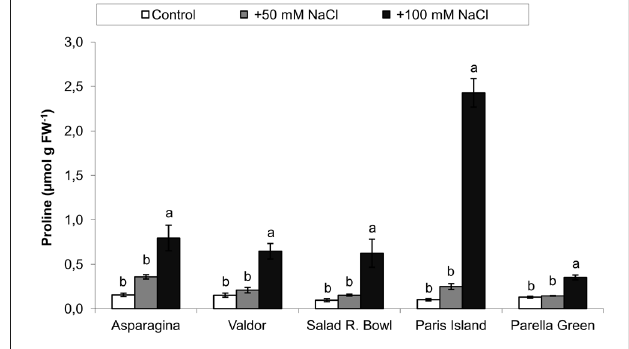
Fig. 6: Proline content of five lettuce cultivars exposed to salt stress. FW – fresh weight. Bars represent means ± SE, n = 5. Different letters in - dicate significant differences among treatments of the same cultivar, at P < 0.05, according to the Tukey